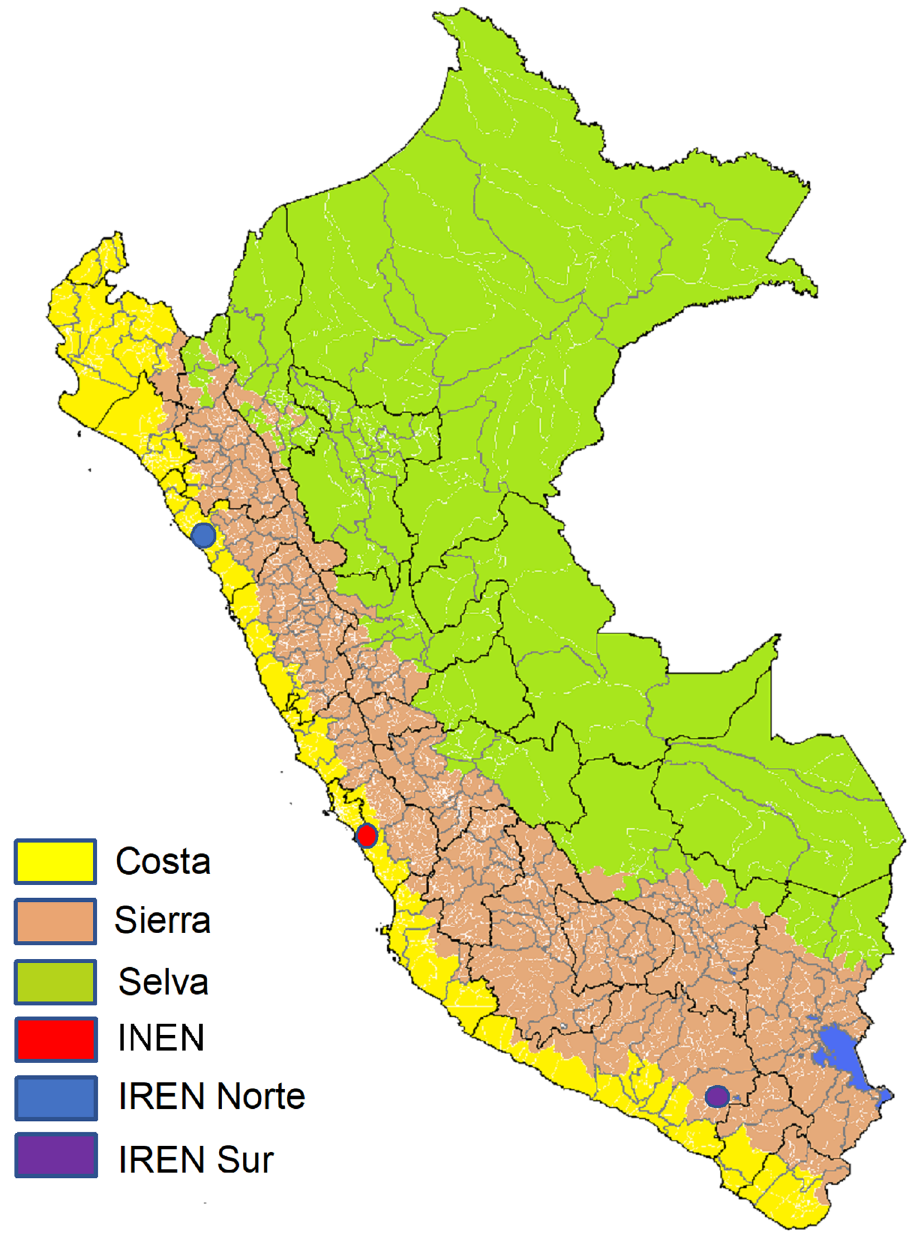
Fig 1. Geographical map of Peru. Different regions are colored. Green: “Selva” Amazonian region, Peach: “Sierra” Mountain region, Yellow: “Costa” Costal region, Red: “INEN location, Blue: “IREN Norte, Purple: “IREN Sur”.